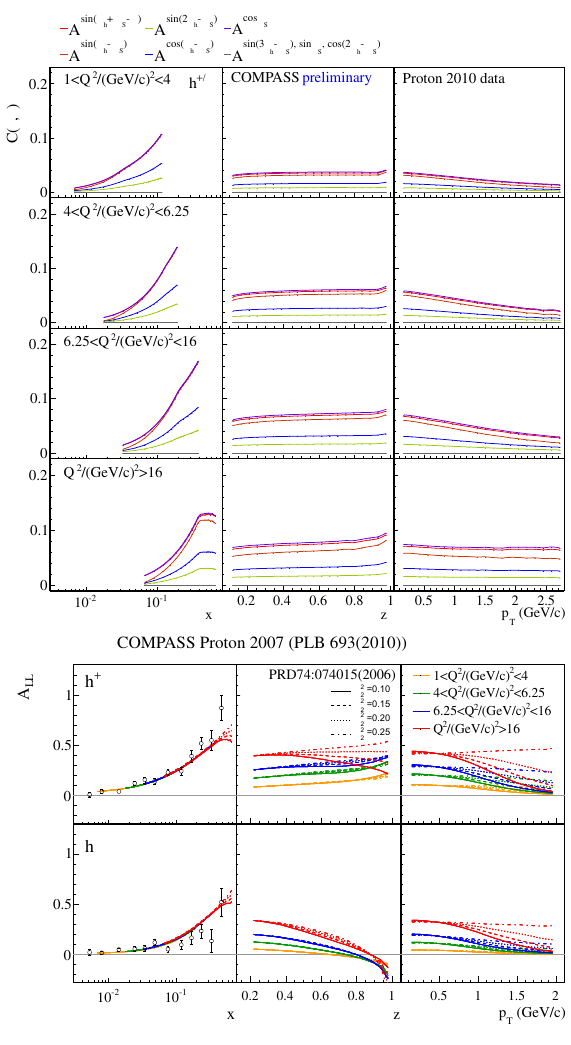
Figure 4. Top: mean C ( ε,θ )-factors from Table. 2. Bottom: A LL asymmetry, COMPASS data [15] and predictions